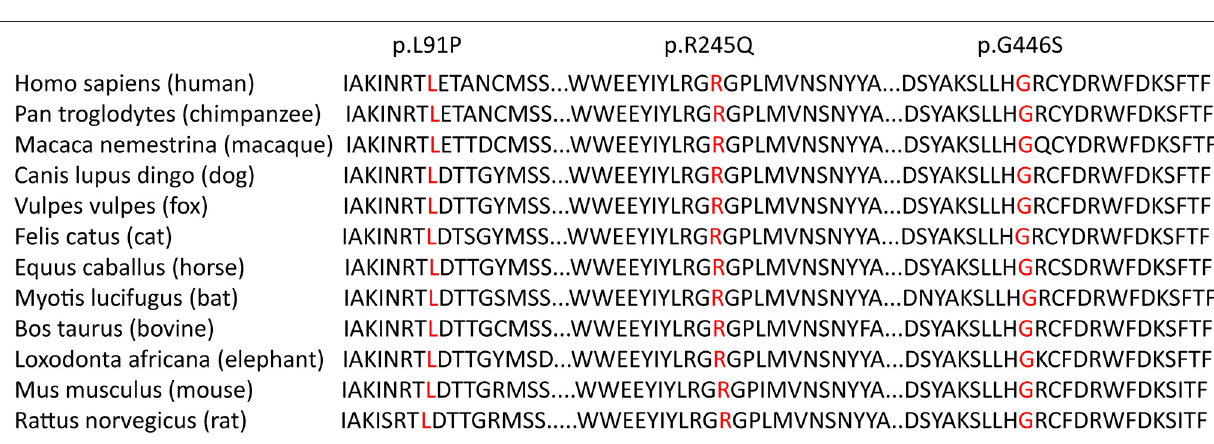
FIGURE 2 | Multiple sequence alignment using ClustalX. Alignment of the CPT1A sequences revealed that the amino acid residues at positions 91, 245, and 446 (highlighted in box) were strictly